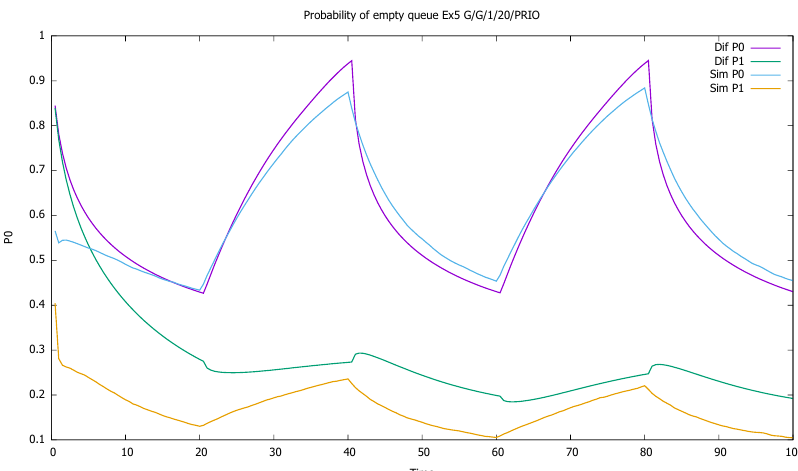
Figure 19. Section 3.5: probabilities of empty queues for priority (P0) and non-priority (P1) classes for very high values of C 2